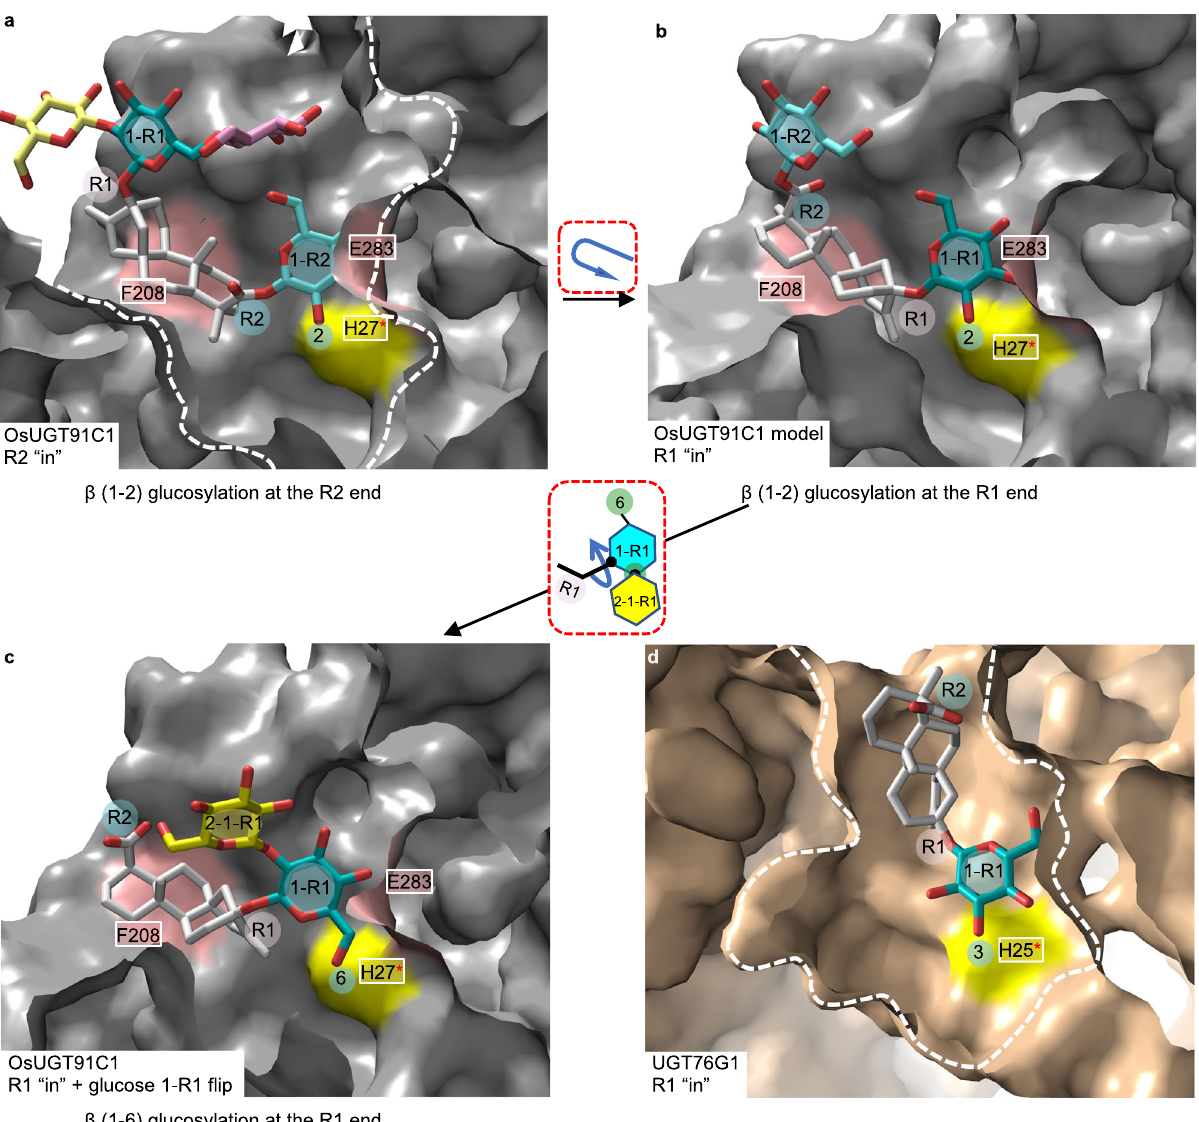
Fig. 5 Origins of OsUGT91C1 promiscuity. a OsUGT91C1 binds Reb E with the R2 end at the active site is ready to add glucose 2-1-R2 to glucose 1-R2. The protein is represented in the surface, and the loose- fi tting substrate tunnel of OsUGT91C1 is delimited by white dashed lines. The catalytic residue His27 is colored yellow (marked with a red asterisk), and the residues Phe208 and Glu283 are colored salmon on the surface. Phe379 cannot be seen as a result of the cutaway surface presentation, and this residue is shown in Fig. 3c – e. The positions of the R1 and R2 ends, glucose units, the reactive 2-hydroxyl, and 6-hydroxyl are labeled with a circle shadow for clarity. b OsUGT91C1 is able to bind the aglycone in the opposite orientation (the transition is shown in the red dashed box) so that the R1 end is now at the active site positioned for the addition of glucose 2-1-R1 to glucose 1-R1. The fi gure uses the same design as glucose 2-1-R1 is held in a new pocket, freeing up the enzyme to bind fresh UDP-glucose and positioning the 6-OH of glucose 1-R1 for catalysis. The fi gure uses the same design as a . d Structurally related β (1 – 3) glycosyltransferase UGT76G1 (Fig. 1b) binds the aglycone in a different location. As a result,